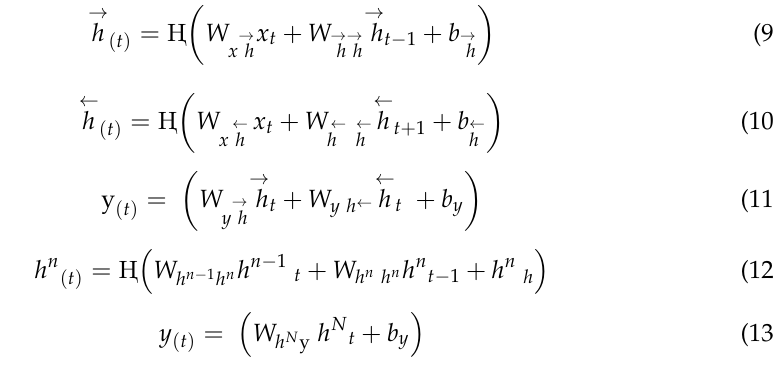
Figure 7. The structure of the BI-LSTM unit [53]. Copyright © 2021 Elsevier. → ← h and the backward hidden h layers are the main parameters The forward hidden of BI-LSTM, presented in Equations (9) and (10), respectively. Equation (11) represents a → ← h and the backward hidden h layers. Backpropagation combination of the forward hidden over time is employed to learn the parameters from the training data, using the output sequence y ( to iterate the backward layers based on the error function. The hidden layers t ) ( Ң ) are used for N stack layers, and the hidden vector series h n is computed sequentially via n ( n = 1) to N ( t = 1, . . . , T ), as indicated in Equation (12). In addition, h 0 = x . y t denotes the network’s ultimate output, as illustrated in Equation